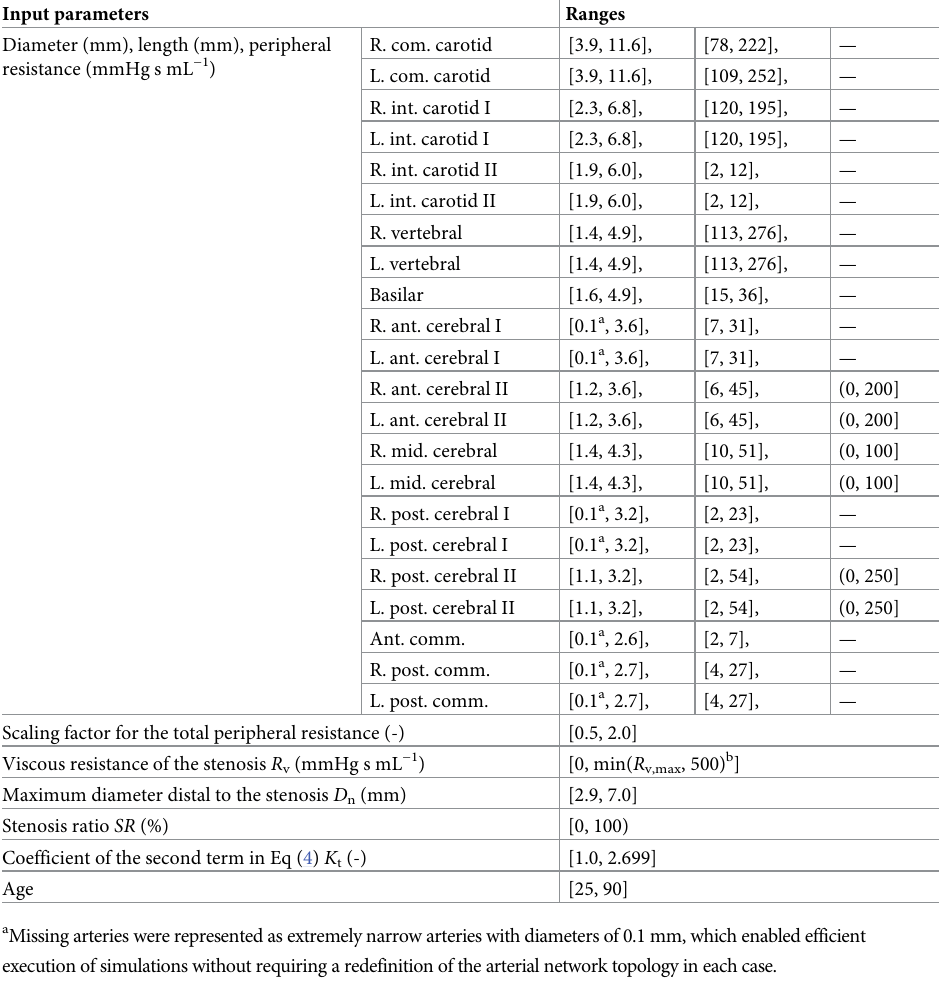
Table 2. Sampling ranges of inputs used to generate the learning data. Input parameters